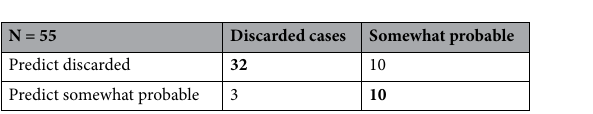
Table 3. Confusion matrix for Group 1 classifications in untrained data.